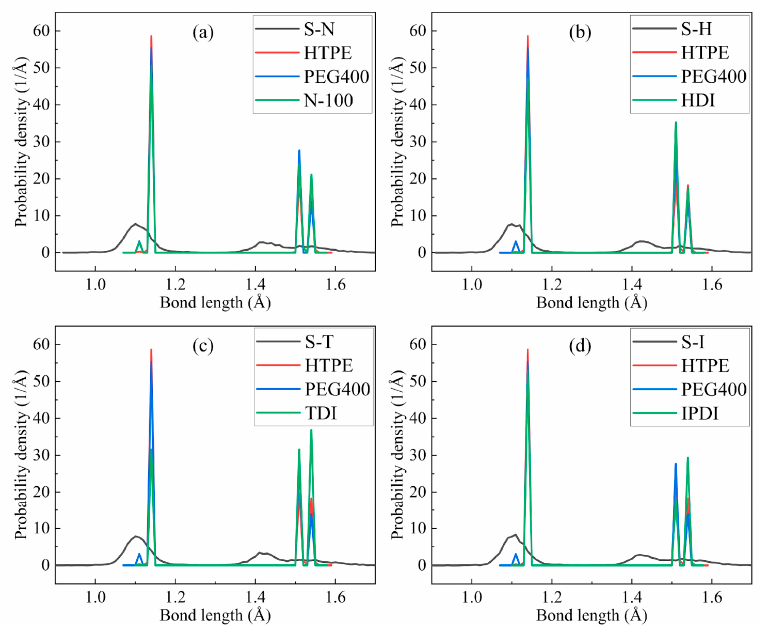
Figure 4. The bond-distributions of four interpenetrating polymer structure binder models. ( a ) S-N, ( b ) S-H, ( c ) S-T and ( d ) S-I.